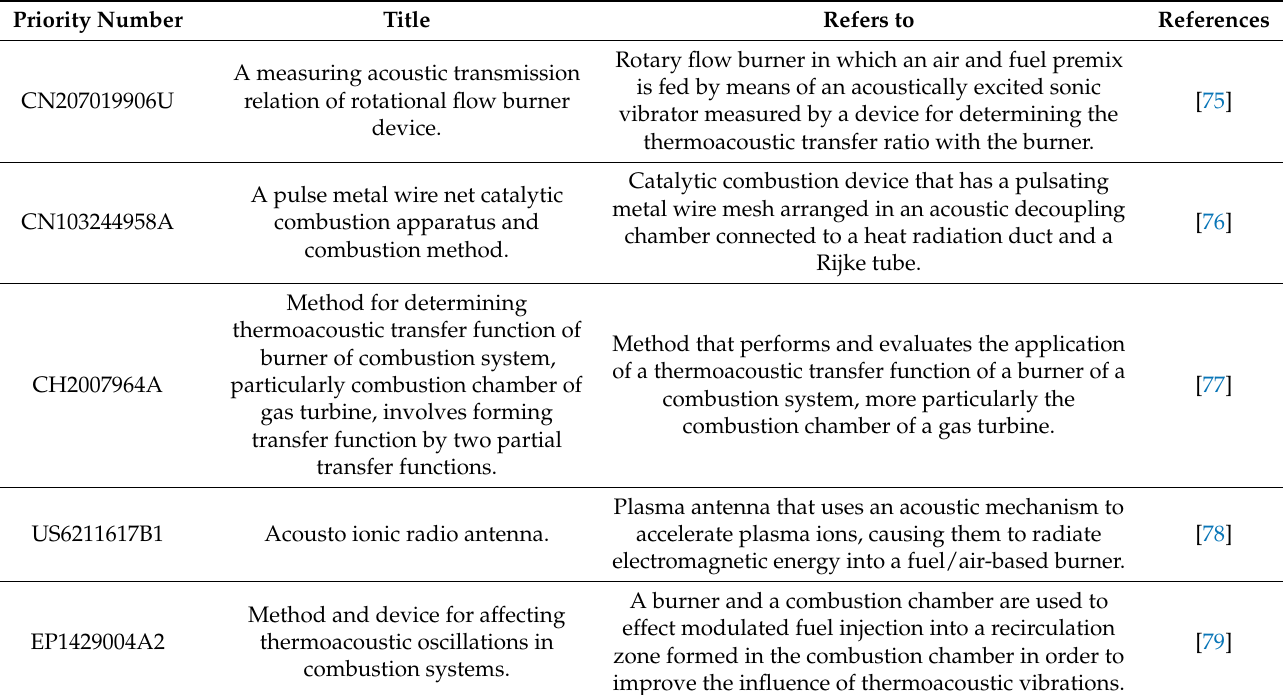
Table 3. Patent documents involving technologies that associate the use of OEC and acoustic excitation with the combustion